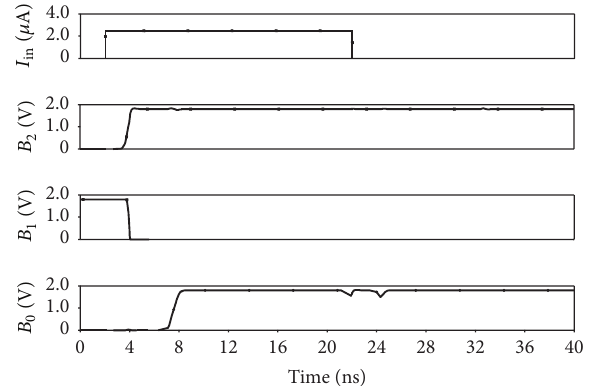
Figure 15: Output of a two-step CM flash ADC based on proposed comparator.